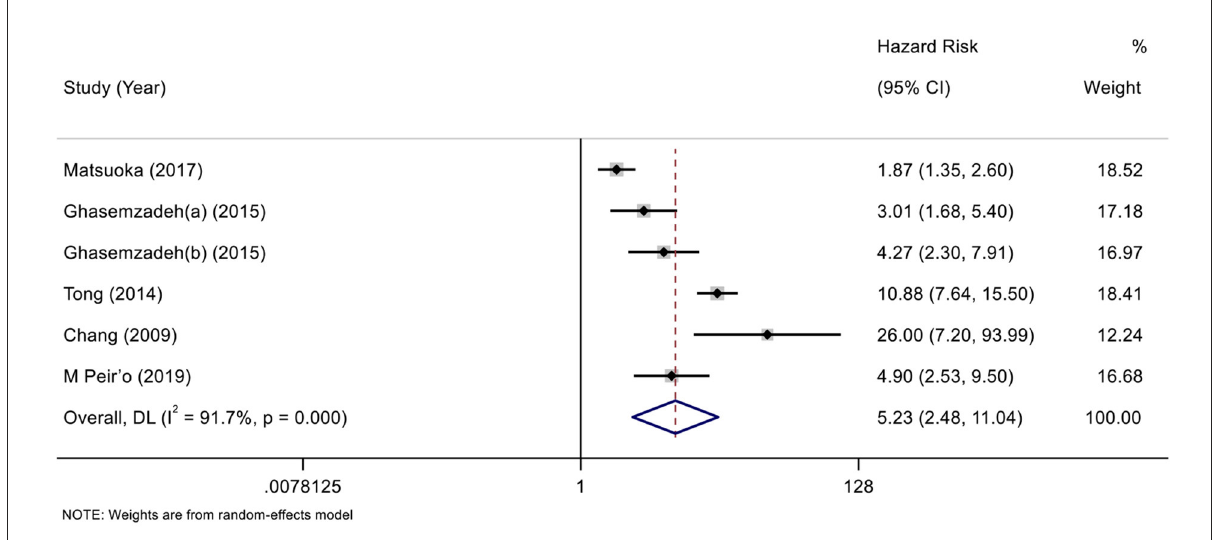
FIGURE2 Forest plot of the association between C-X-C motif chemokine 12 (CXCL12) level as category variable and major adverse cardiovascular events (MACEs) in patients with coronary artery disease (CAD) (univariate analysis).